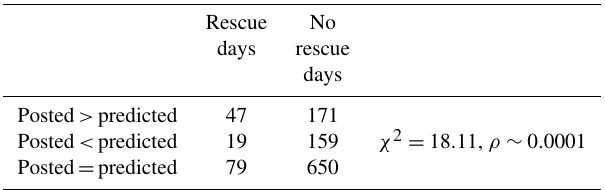
Table 2. Results of χ 2 analysis of posted and predicted flag colour versus rescue and no rescue days at Pensacola Beach, Florida, be- tween 2004 and 2008.